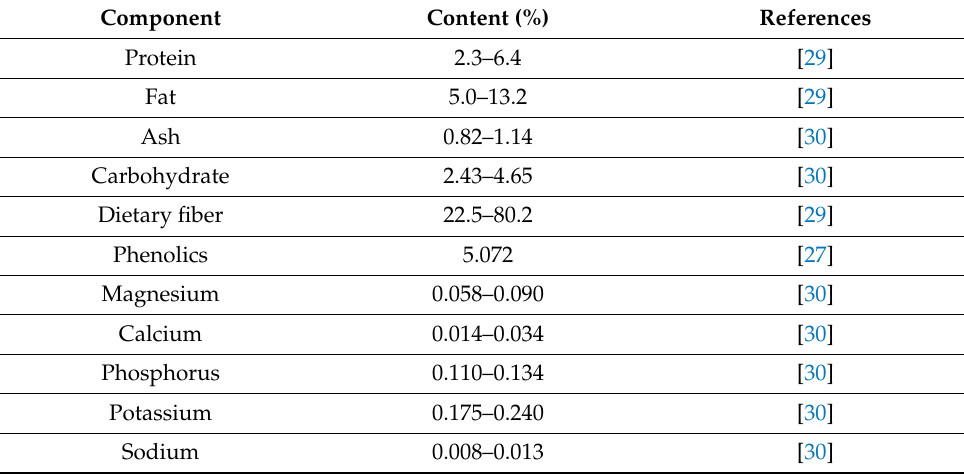
Table 1. A summary of the highly extractable and valuable components of data